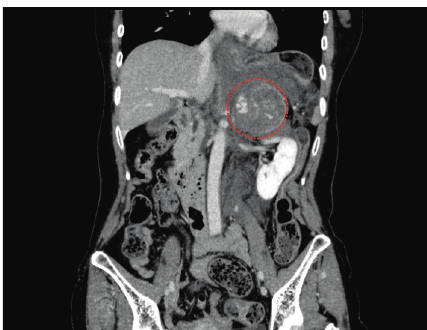
Figure 1: Computed tomography findings on admission. Contrast- enhanced coronal abdominal computed tomography showed a left 5.7cm adrenal mass (red dots) and a large retroperitoneal